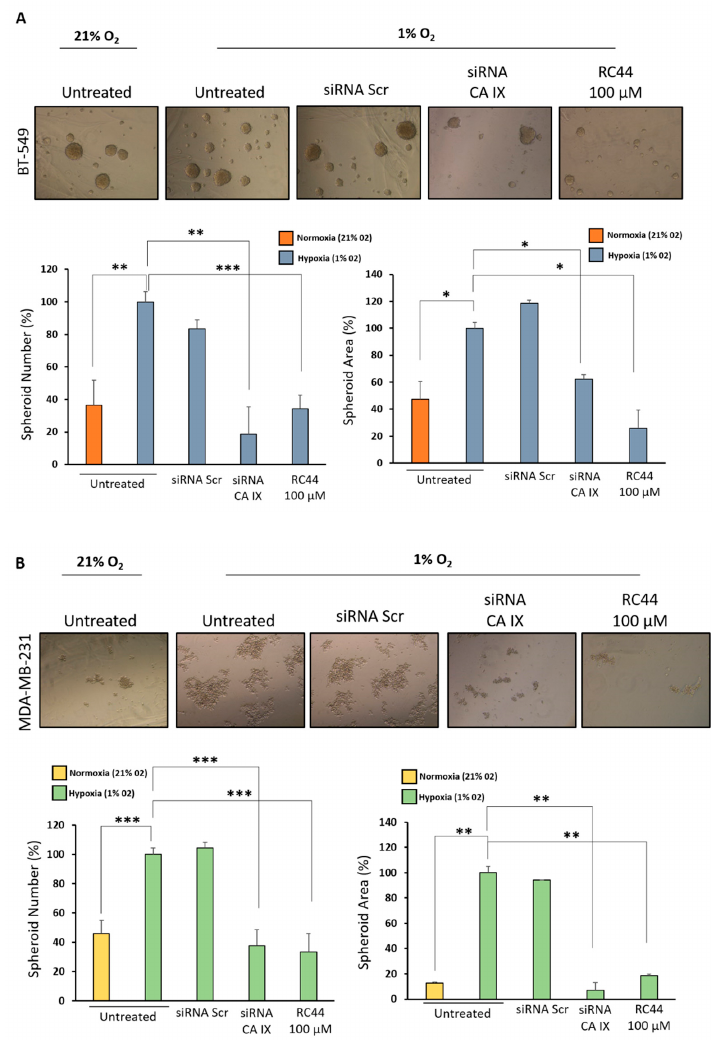
Figure 7. Targeting CA IX reduces the transformation of TNBC cells in cancer stem-like cells. BT-549 ( A ) and MDA-MB-231 ( B ) cells were seeded in ultra-low attachment multiwall plates and grown in serum-free DMEM supplemented with B27, bFGF (20 ng/mL) and EGF (10 ng/mL) in normoxic and hypoxic conditions for seven days. TNBC cells grown in 1% O 2 were transfected with siRNA CA IX (100 nM) and siRNA Scr (100 nM) or treated with RC44 (100 µM) and grown as described above. Spheroid formation was analyzed under a phase-contrast microscopy and size and number of formed spheroids was calculated using ImageJ. Bars depict mean ± SD of three independent experiments. *** p < 0.0001; ** p < 0.001; * p < 0.01.